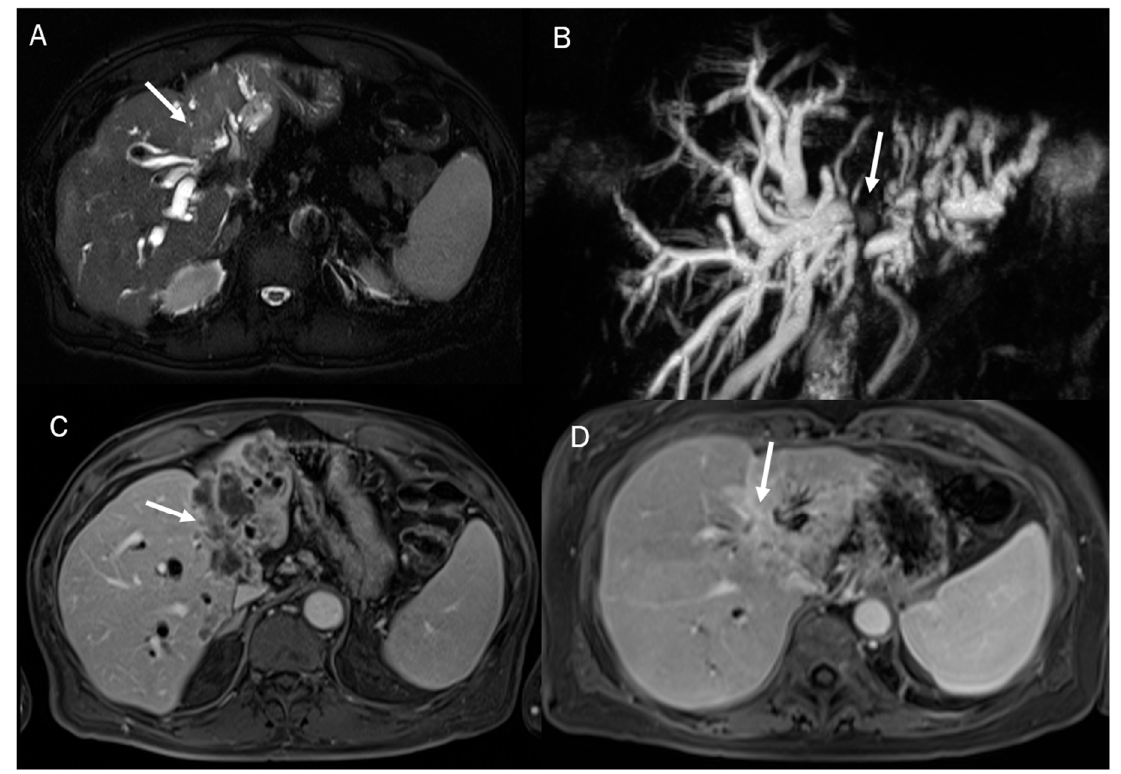
Figure 6. MRI assessment of periductal-infiltrating CCA. The lesion (arrow) shows hyperintense signal in T2-W ( A ), causing biliary tree dilatation in cholangiography sequences ( B ). During arterial phase ( C ), the lesion causes hyperenhancement of surrounding liver parenchymal, showing a progressive contrast enhancement in portal phase ( D ).